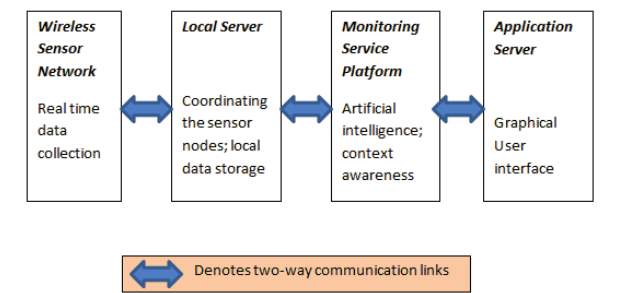
Fig. 1 Integrated communication